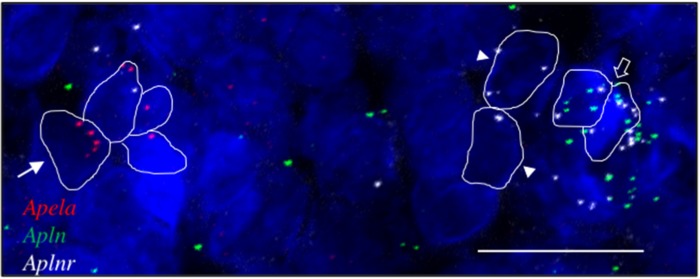
Aplnr, apln and apela transcripts in the SHR AP.Representative fluorescent images showing cells expressing apela (red dots; arrowed), aplnr (white dots, arrowheads) and apln (green dots). Cells co-expressing aplnr and apln are indicated (open arrow). Scale bar = 50μm. n = 4.